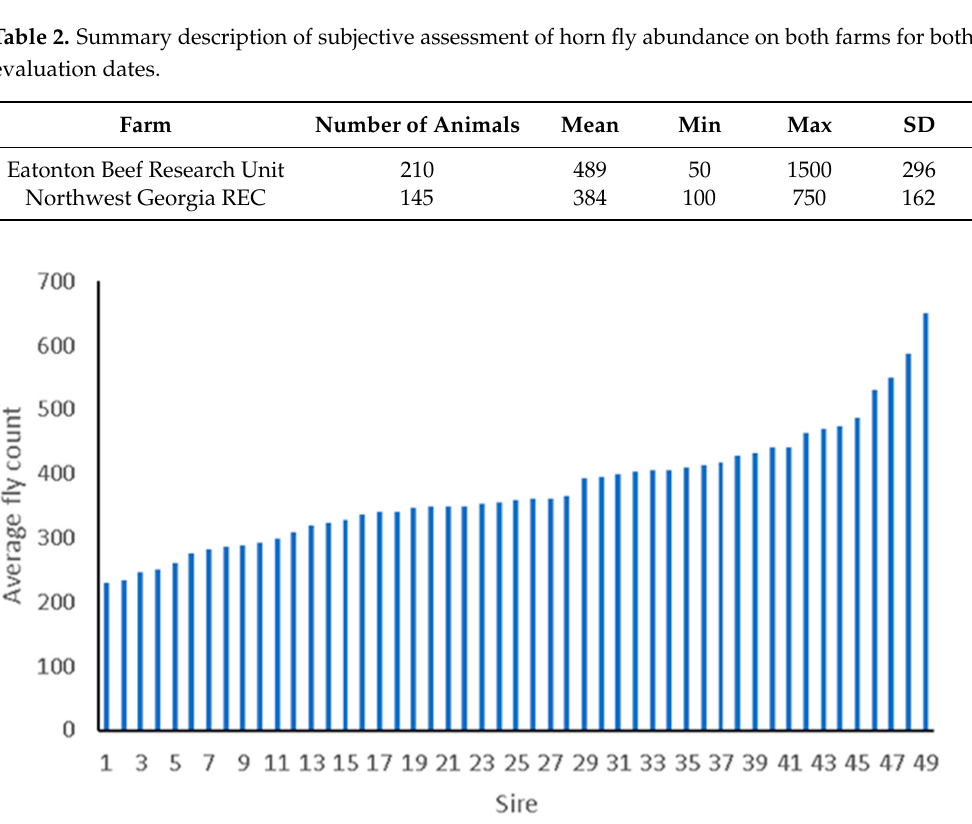
Figure 1. Average fly count for sire families. Only sires with 3 or more progeny were included. Across two replicates, there was a clear consistency in the relationship between OD reads and thrombin concentration in the standards (Figure 2).